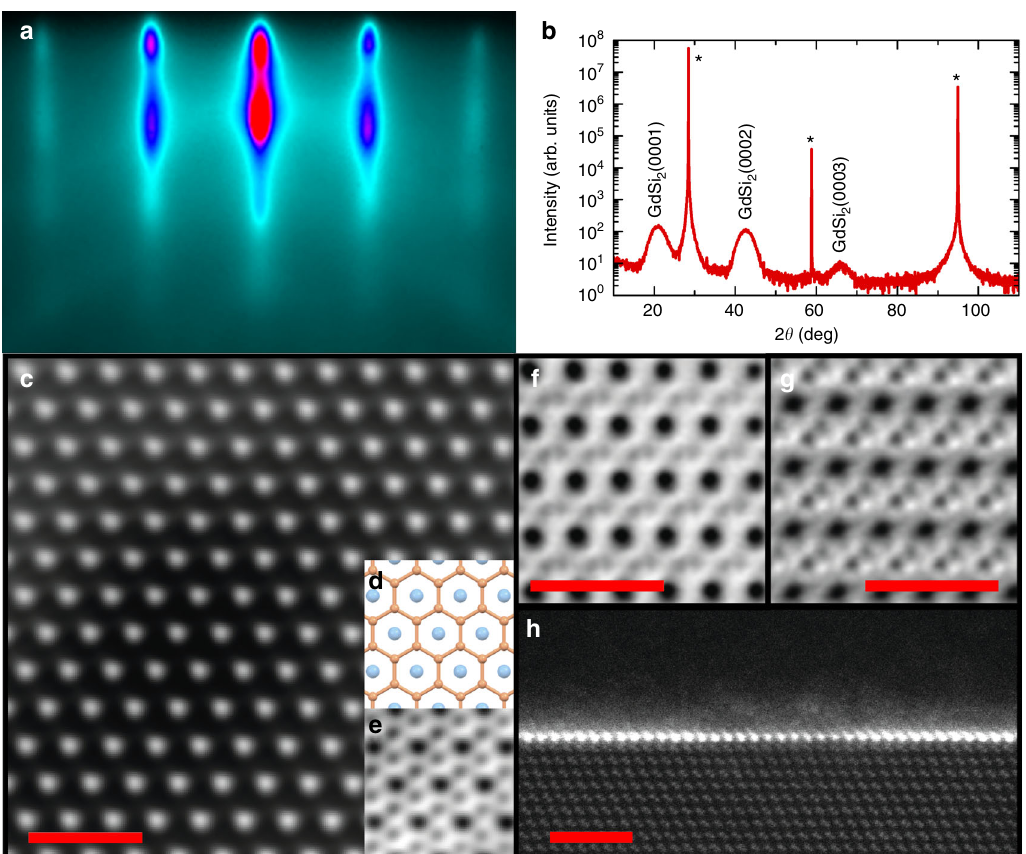
(cid:1) (cid:3) azimuth of the Si substrate. b θ -2 θ X-ray diffraction